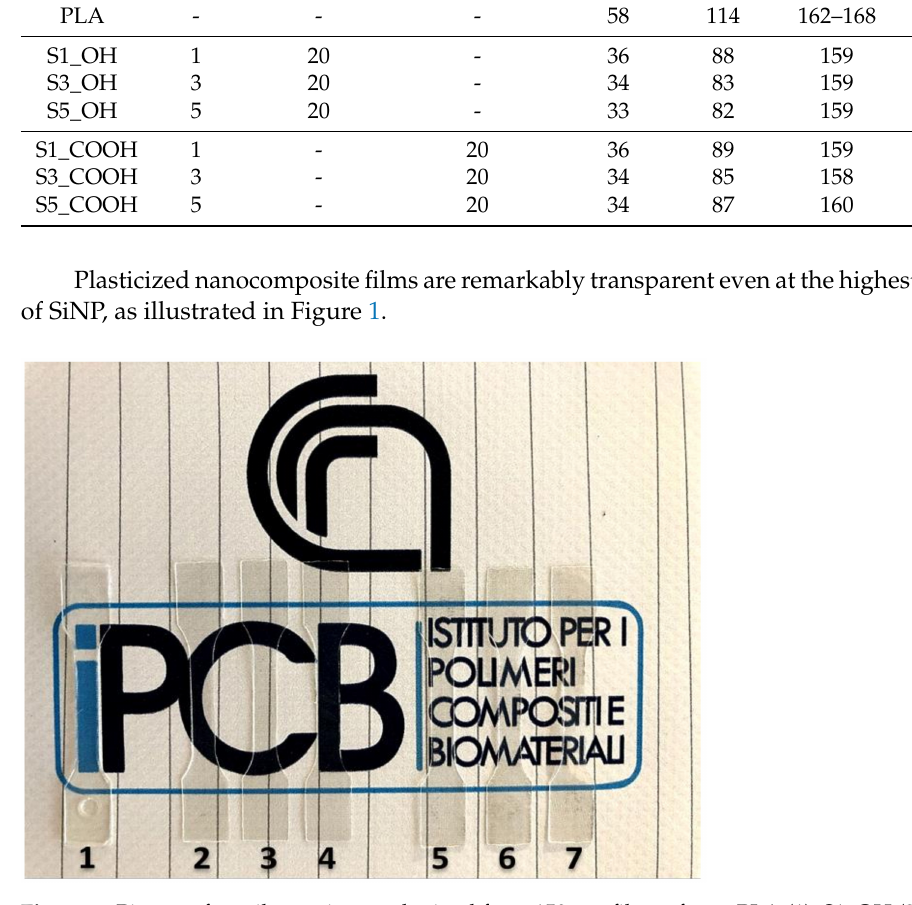
Figure 1. Picture of tensile specimens obtained from 150 µ m films of neat PLA (1), S1_OH (2), S3_OH (3), S5_OH (4), S1_COOH (5), S3_COOH (6), S5_COOH